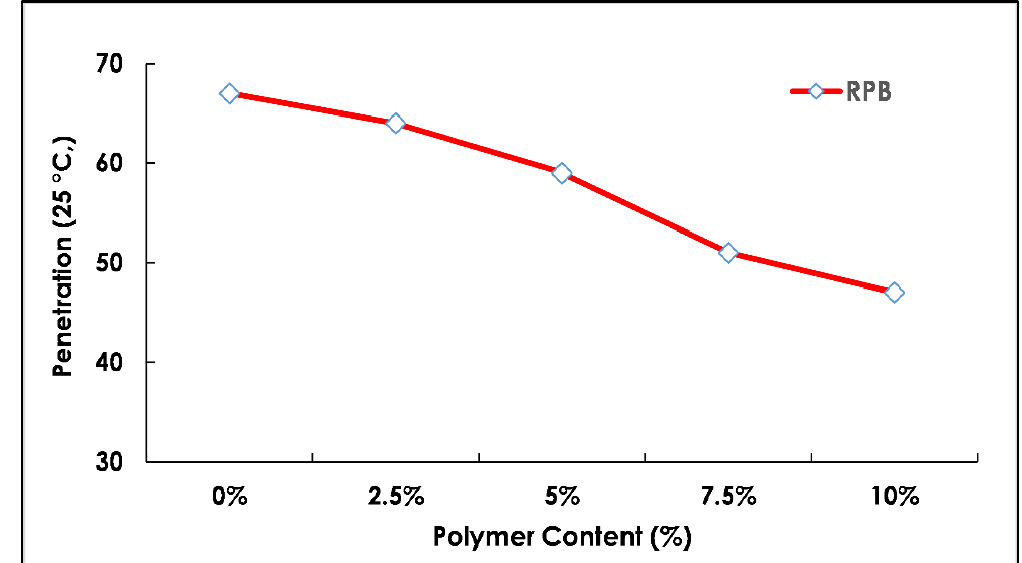
Figure 7 . Penetration test results with varying polymer content (%). Figure 7. Penetration test results with varying polymer content (%).